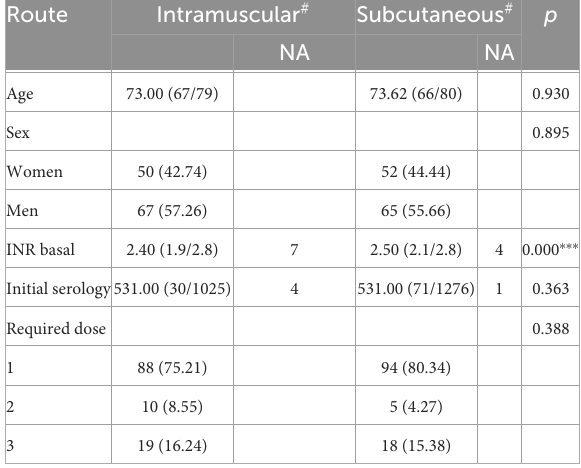
TABLE 1 Bivariate analysis by route. TABLE 2 Bivariate analysis of outcome variables.